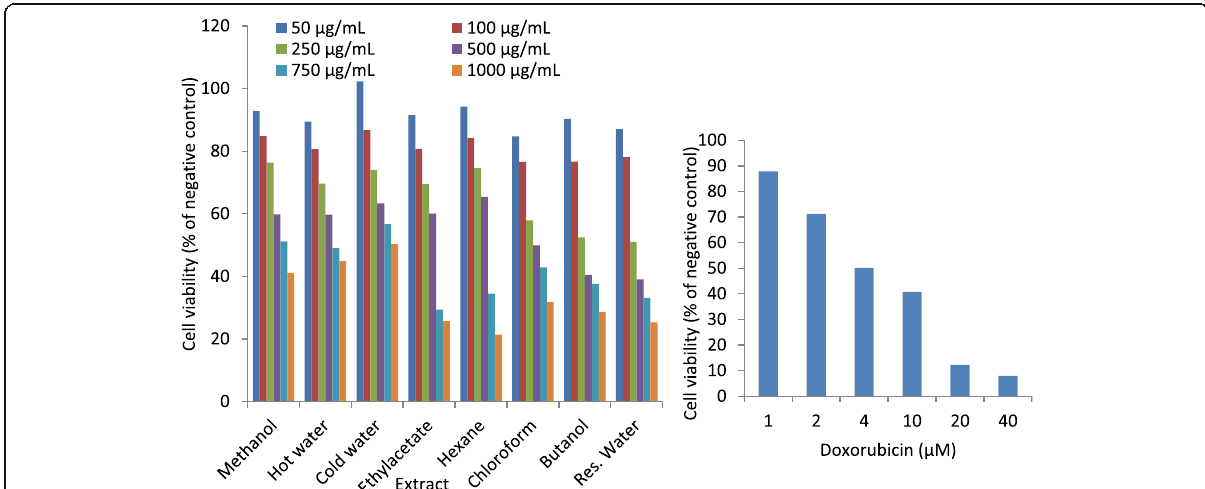
Fig. 2 Antiproliferative activity of Terminalia avicennioides extracts and fractions on Vero cell lines as inhibition of cell viability expressed as percentage (of negative control). Data represent the mean ± SD (standard deviation) of two independent experiments. Values for doxorubicin as positive control are shown for comparison